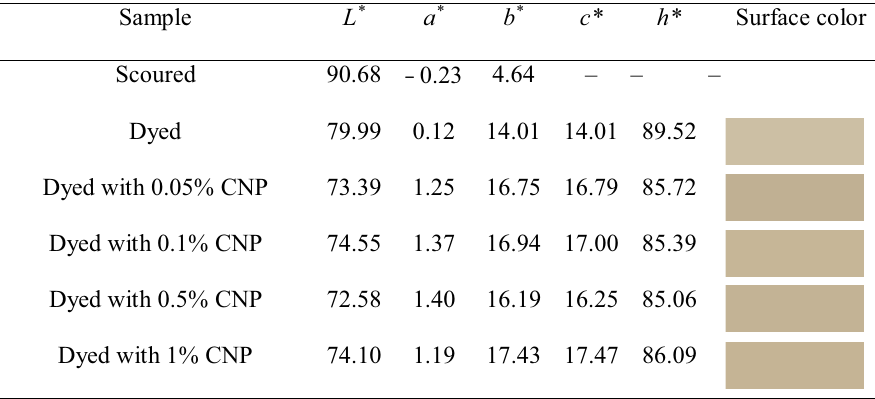
Table 3 Color characteristics of cotton dyed with Euphorbia at different cellulose nanoparticles (CNP)